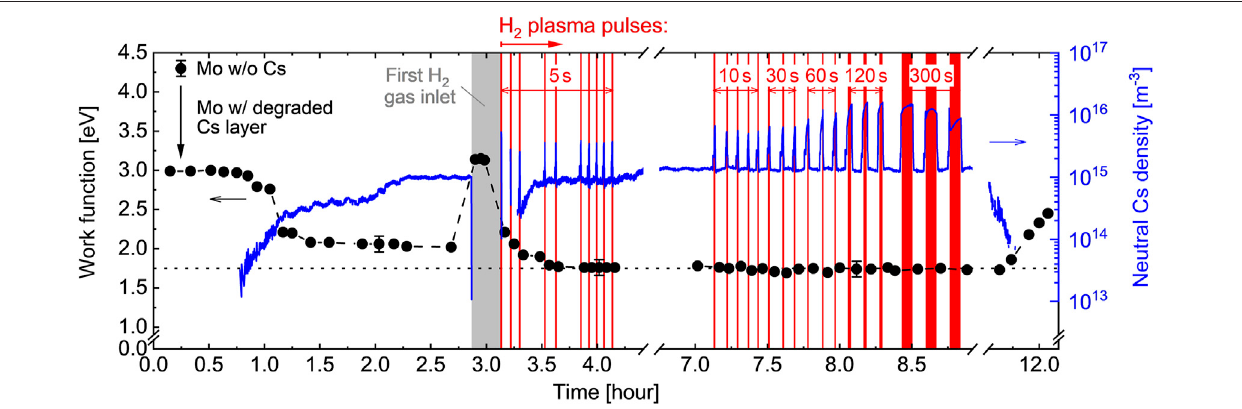
FIGURE11| Temporaldevelopmentofthesurfaceworkfunctionduringacaesiumre-conditioningscenarioapplied atACCesS: adegradedcaesiatedMosurface is re-caesiated and exposed to a sequence of hydrogen plasma pulses with variable length. The neutral caesium density is measured via TDLAS, the plasma-on time is indicated by the red shaded areas (10 Pa gas pressure and 250 W RF power